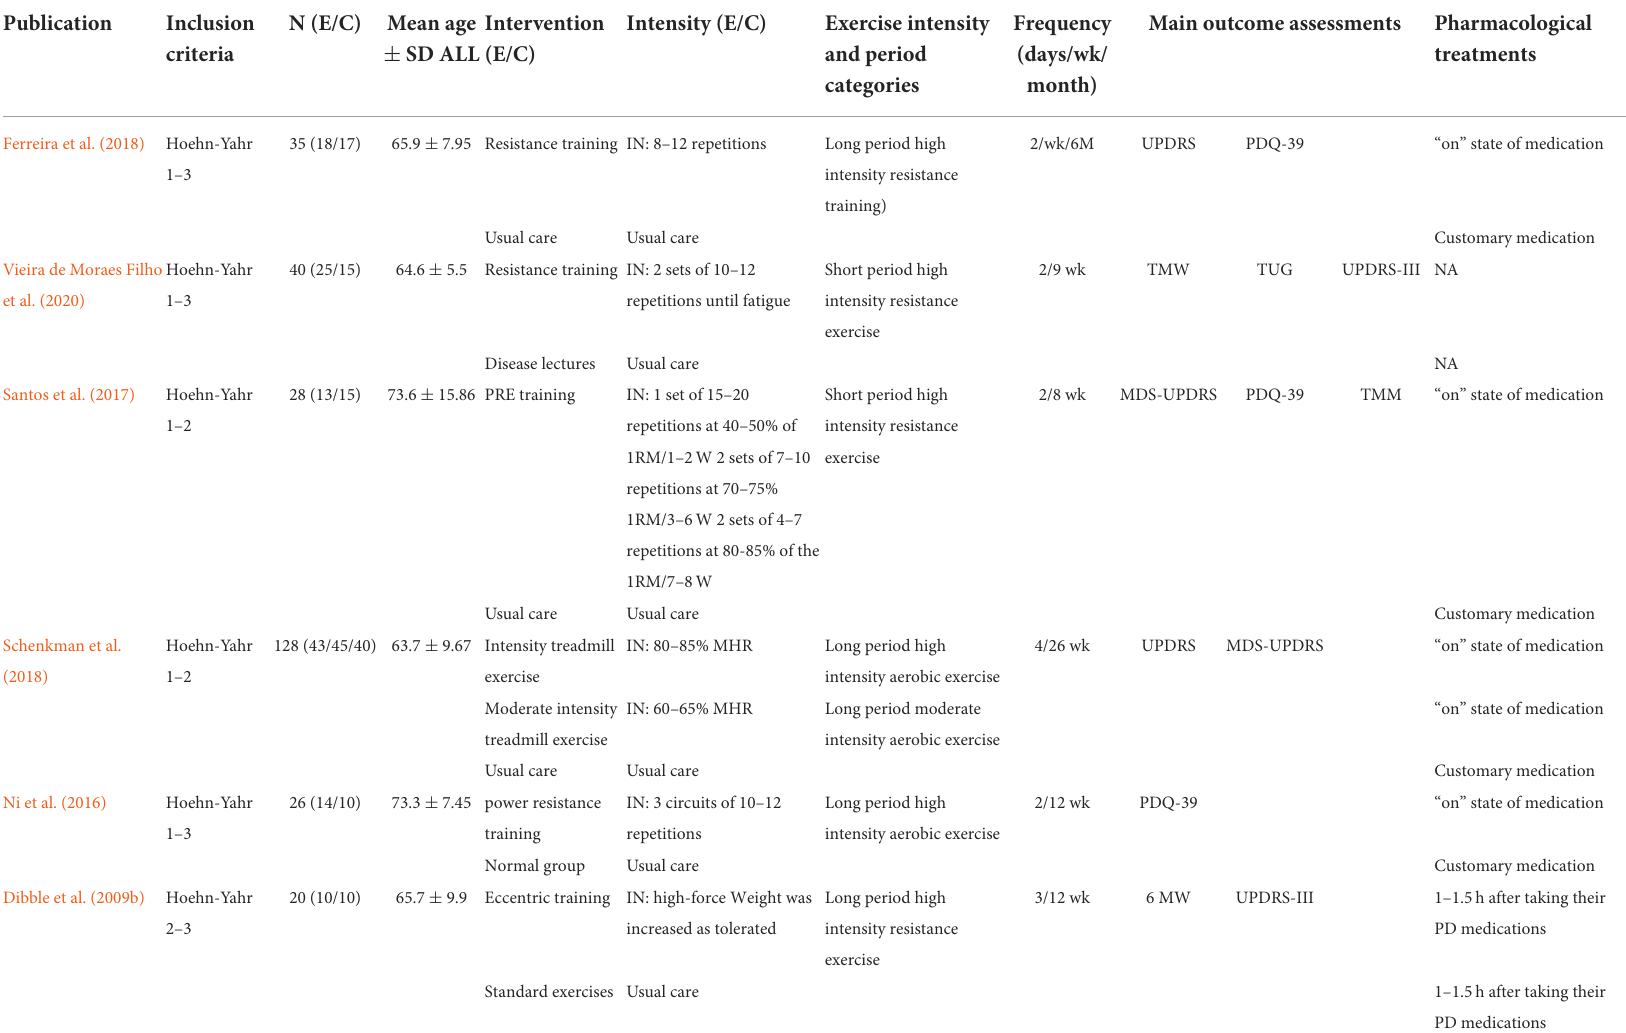
TABLE 3 The specific movement characteristics and classification